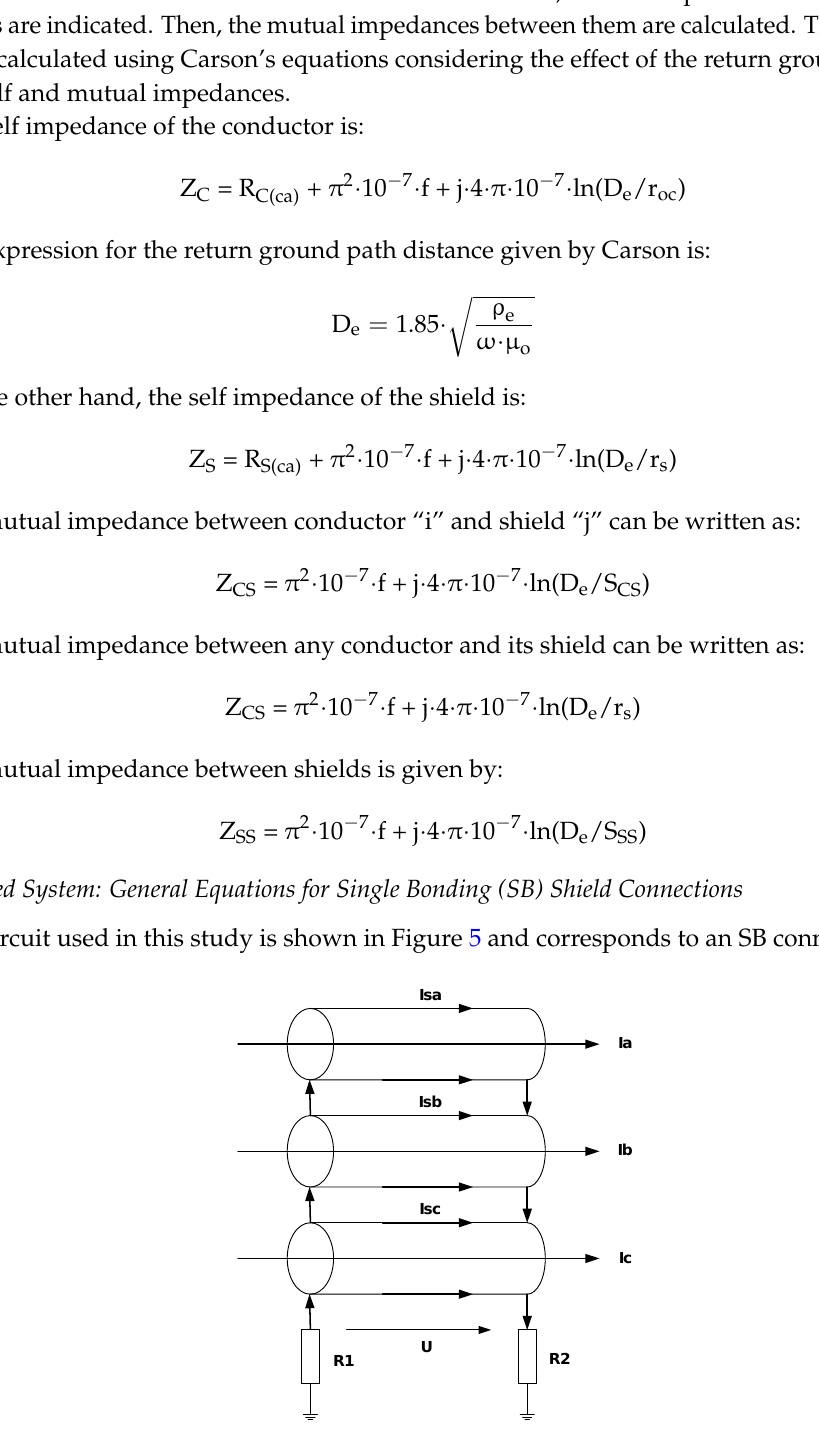
Figure 5. Standard shields connection for SB applications. (I a , I b , I c ) Currents in conductors; (I sa , I sb , I sc ) Currents in shields; (R 1 , R 2 ) Ground resistances at both ends of shields; (U) Potential difference between shield terminals.